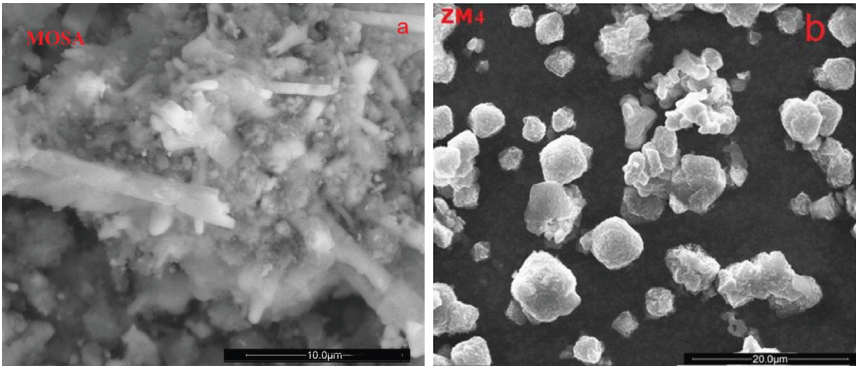
Figure 6: SEM images of MOSA and the synthesis product ZM4 morphology.